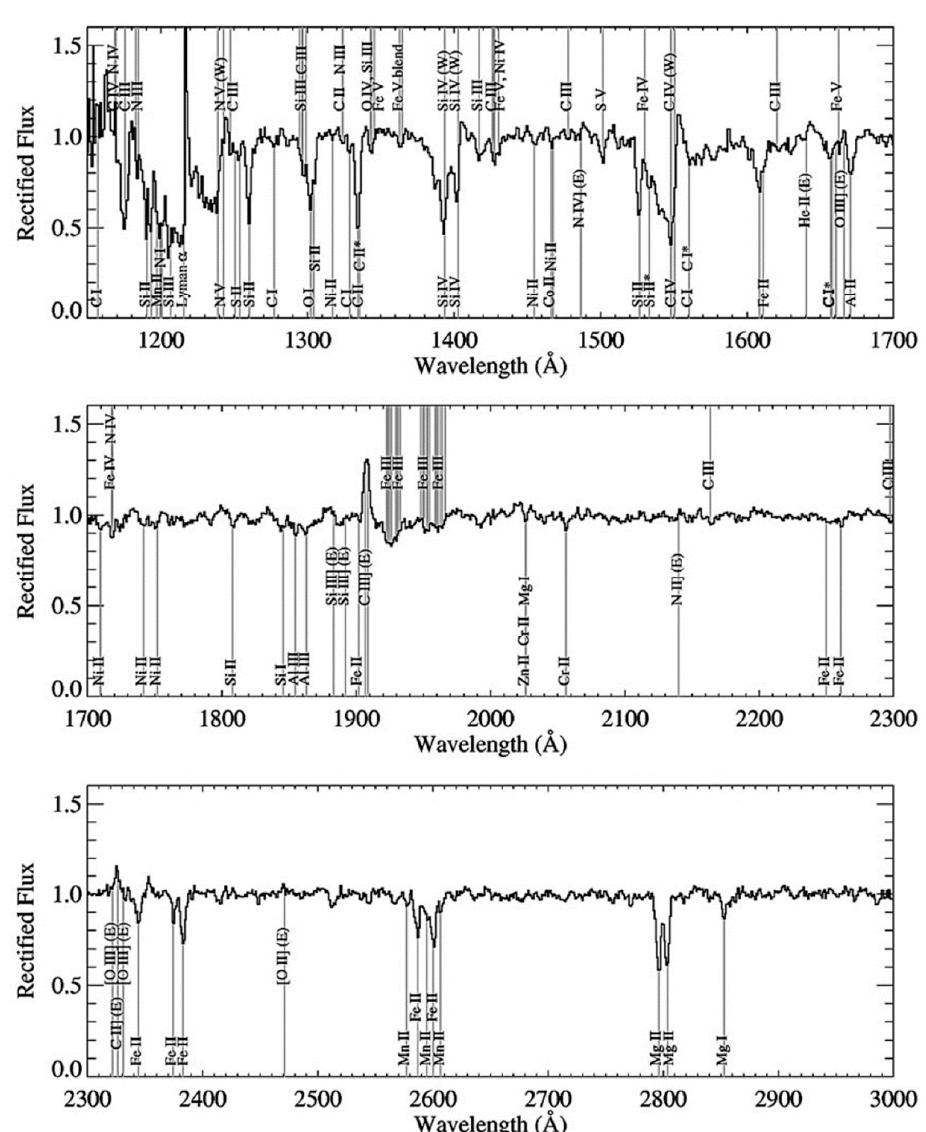
Figure 8. Composite spectrum constructed from a sample of star-cluster spectra obtained with the Faint Object Spectrograph ( FOS ) and the Goddard High Resolution Spectrograph ( GHRS ) onboard HST . Strong interstellar lines are identified below the spectrum; stellar-wind and photospheric lines are labeled above. The wind lines are marked with a ʺ W ʺ . Nebular emission lines are identified with an ʺ E ʺ . From [31].